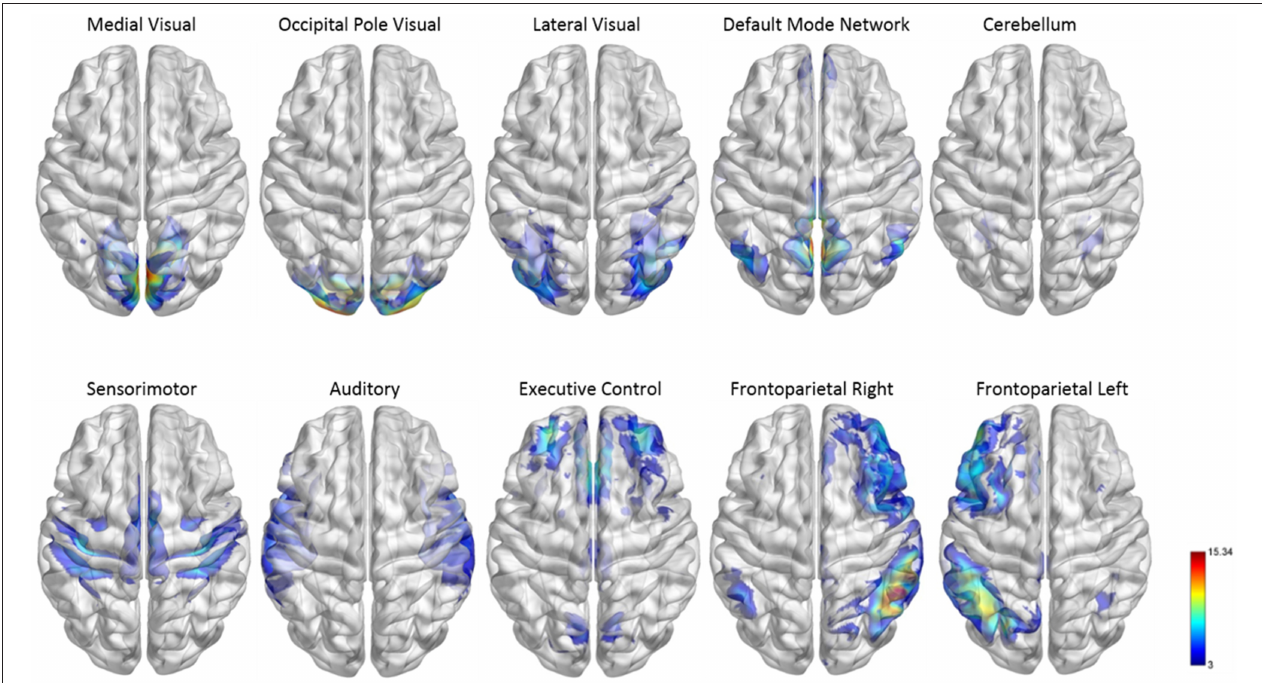
FIGURE 2 | Functional module maps. The functional module z-score maps (thresholded at z > 3) defined by the 10 primary resting state networks (RSNs, Smith et al., 2009). To categorize nodes by module membership, we find the RSN map with the largest z-score in the location of the node, above a certain threshold (z >